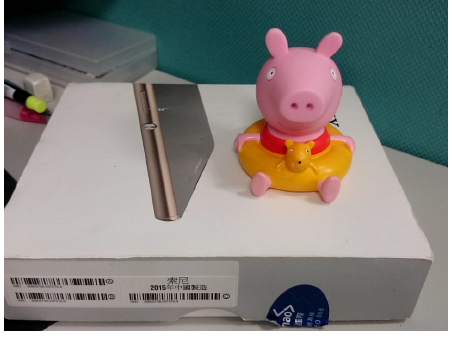
Figure 27. First testing image. Table 3. The score for each composition method in the first testing